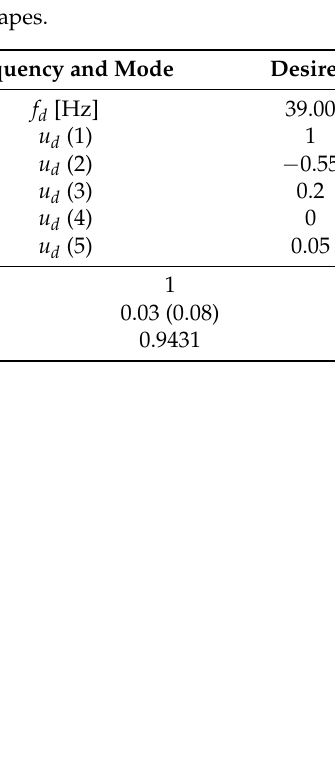
Figure 11. Comparison of desired and attained modes: 39 Hz.